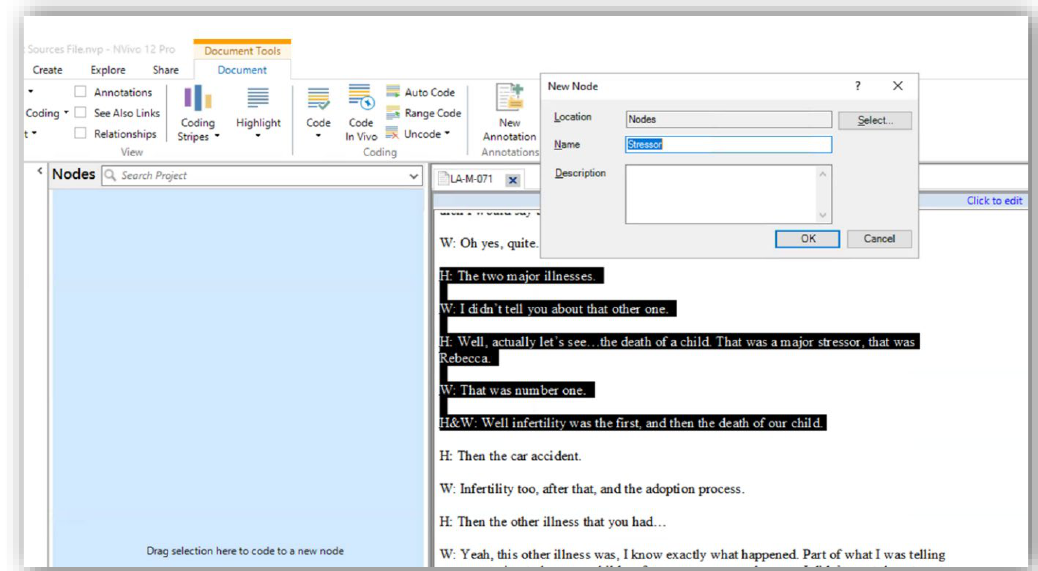
Figure 1. Open coding with the entire interview method screenshot 1 (Steps 1–3).